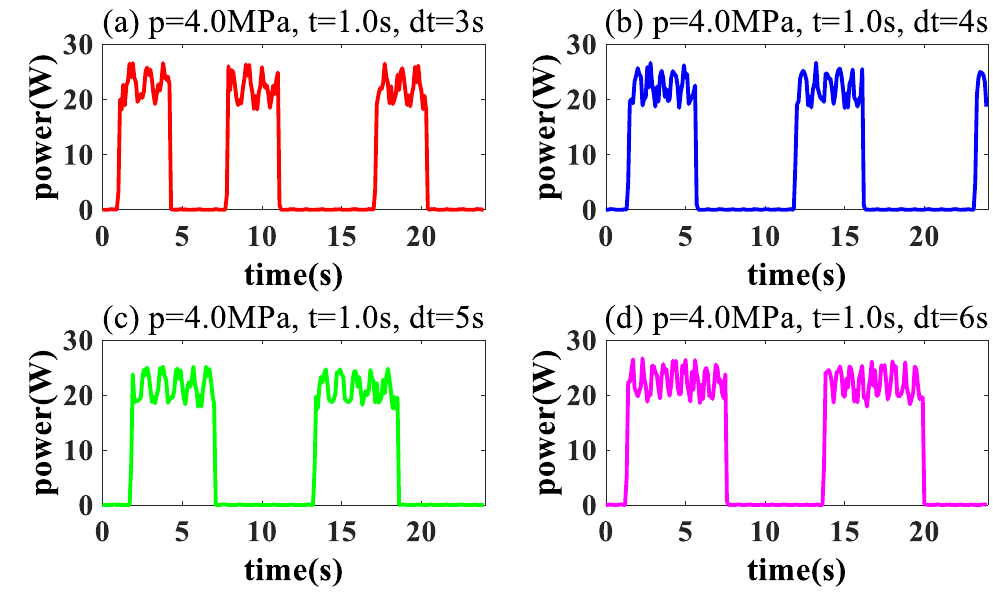
Figure 16. Output power under different open state durations (trigger pressure is 4.0 MPa).